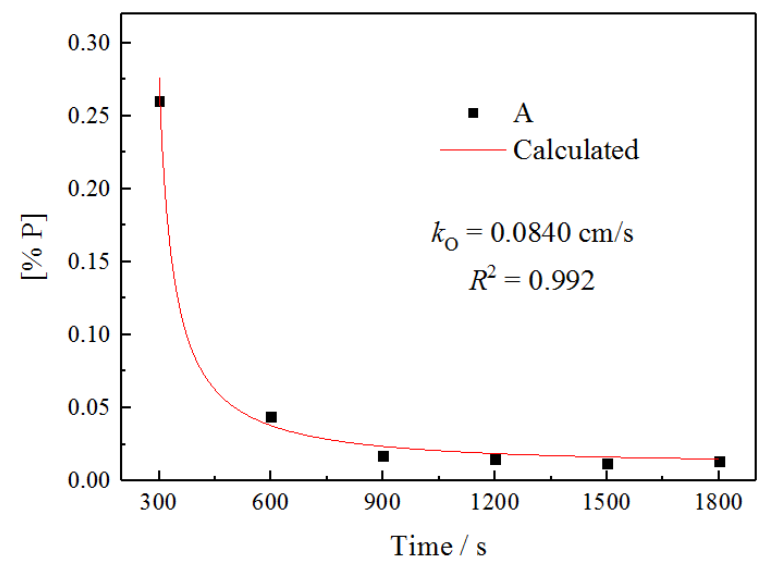
Figure 6. Fitting results of experiment A data.